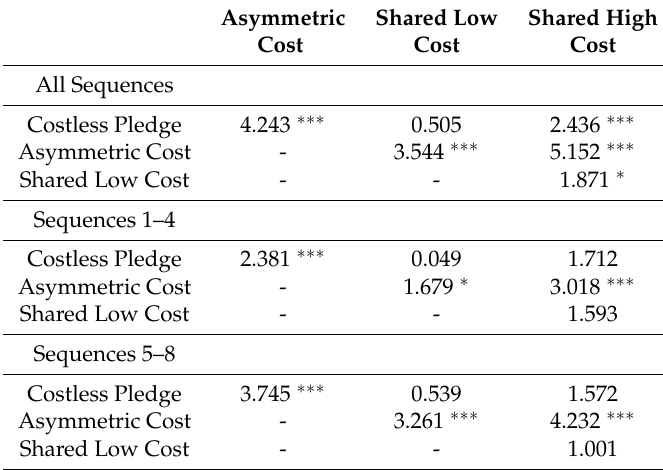
Figure 3. Average contributions by commitment status and sequence. Table 4. Differences in contributions of committed